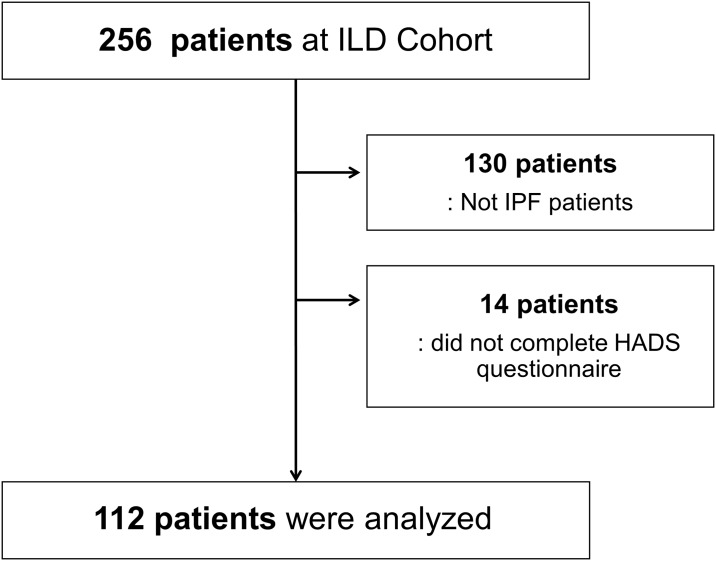
Study flow chart.